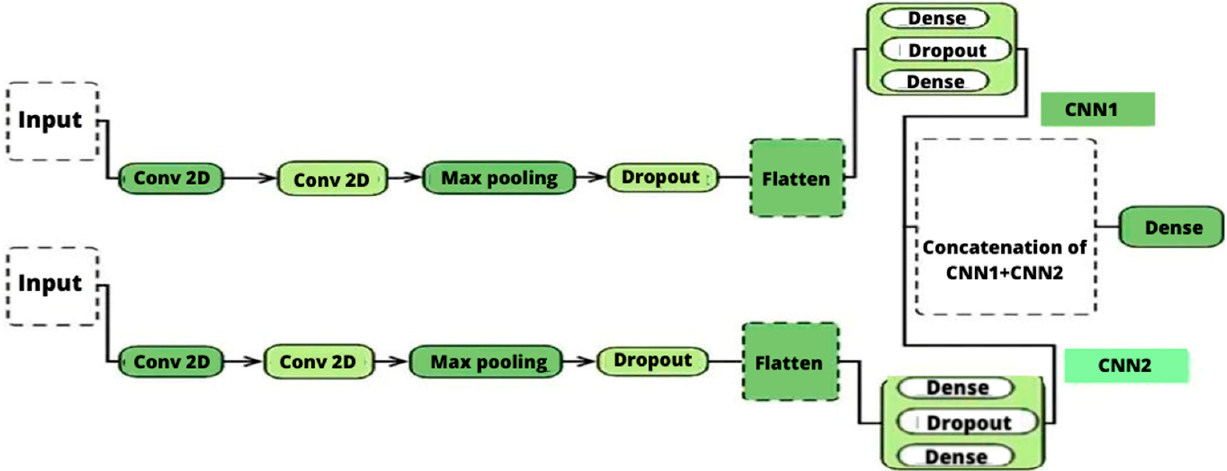
Figure 3. 2-CNN model architecture.